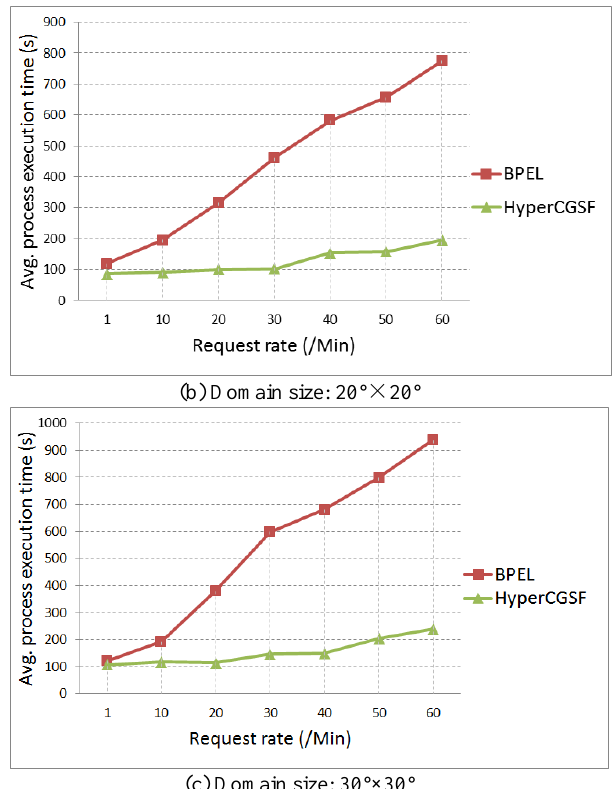
Figure 6: Comparison of average process execution time using different service composition methods for the